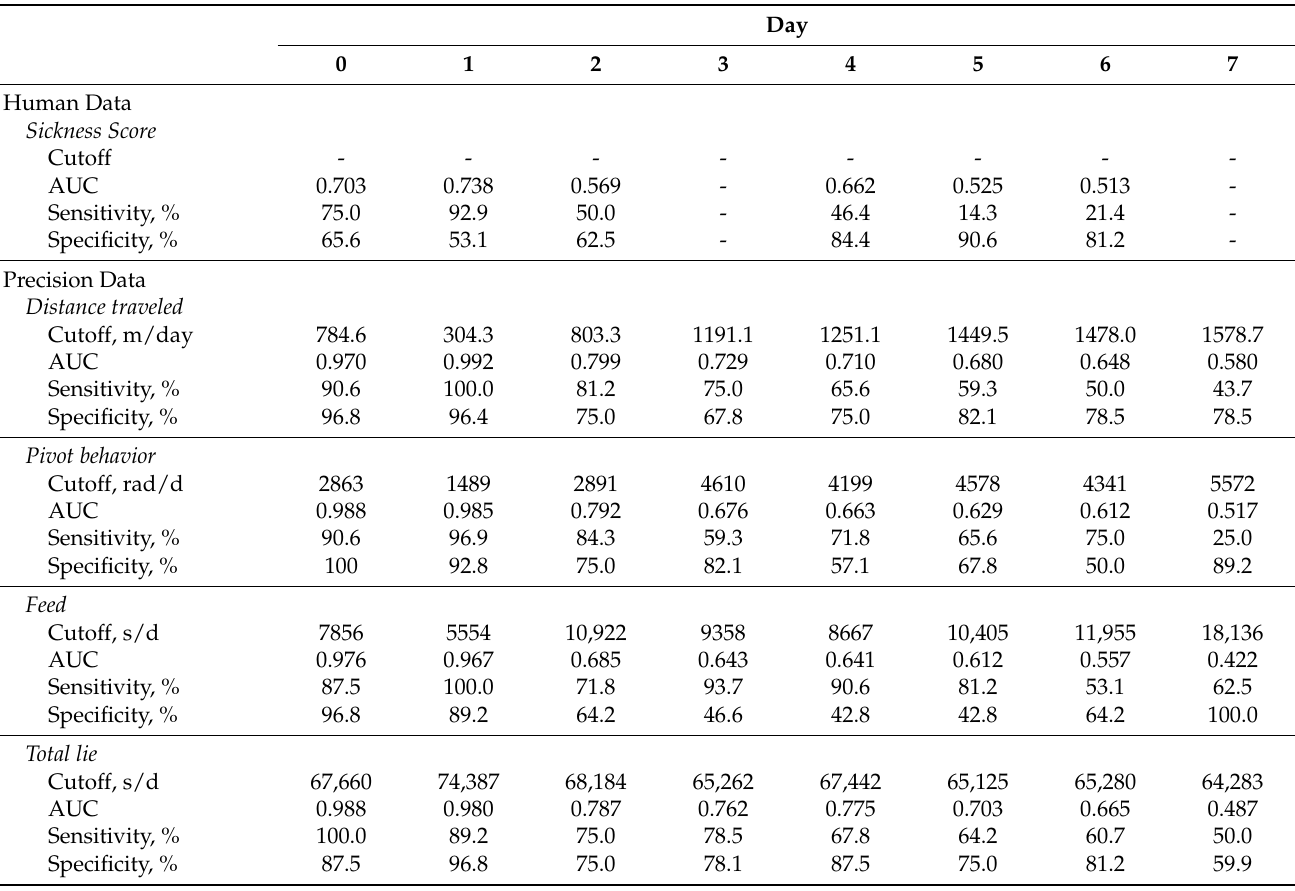
Table 2. Half-and-half nursery pig optimal cutoff values, the area under the curve (AUC), sensitivity, and specificity for human data and precision data (NU track ). Four pens out of sixteen were randomly assigned the half-and-half treatment, then one-half of the pigs were randomly assigned treatments of either sham-handling, (controls; 3 mL saline solution subcutaneous) or single subcutaneous dose of lipopolysaccharide (LPS from E. coli O111:B; 300 µ g/kg of body weight in a total of 3 mL saline). Human real-time live scoring (human data) and data from a precision livestock technology (NU track precision data) were